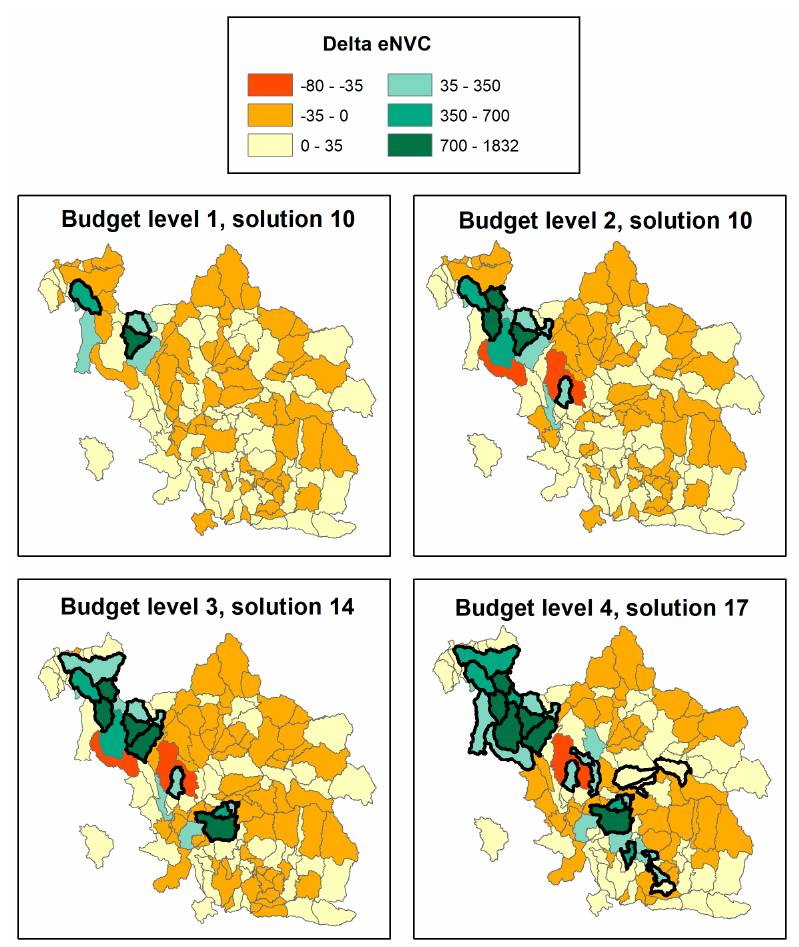
Figure 11. Net change in total POD-level eNVC under four treatment scenarios. Positive values indicate reductions in net loss. Black outlines indicate treated PODs.